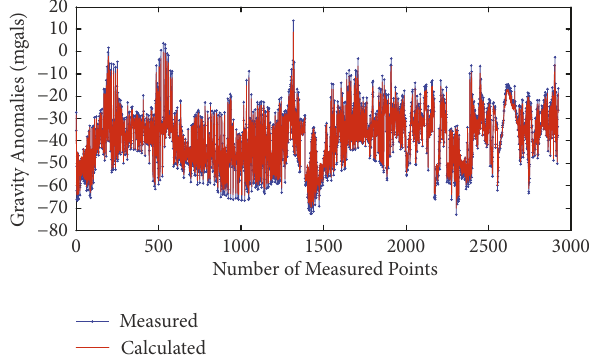
Figure 9: Comparison of present ANN model (blue color) and measured anomalies (red color) for two inputs ( y -axis for Bouguer anomalies and x -axis for gravity stations).